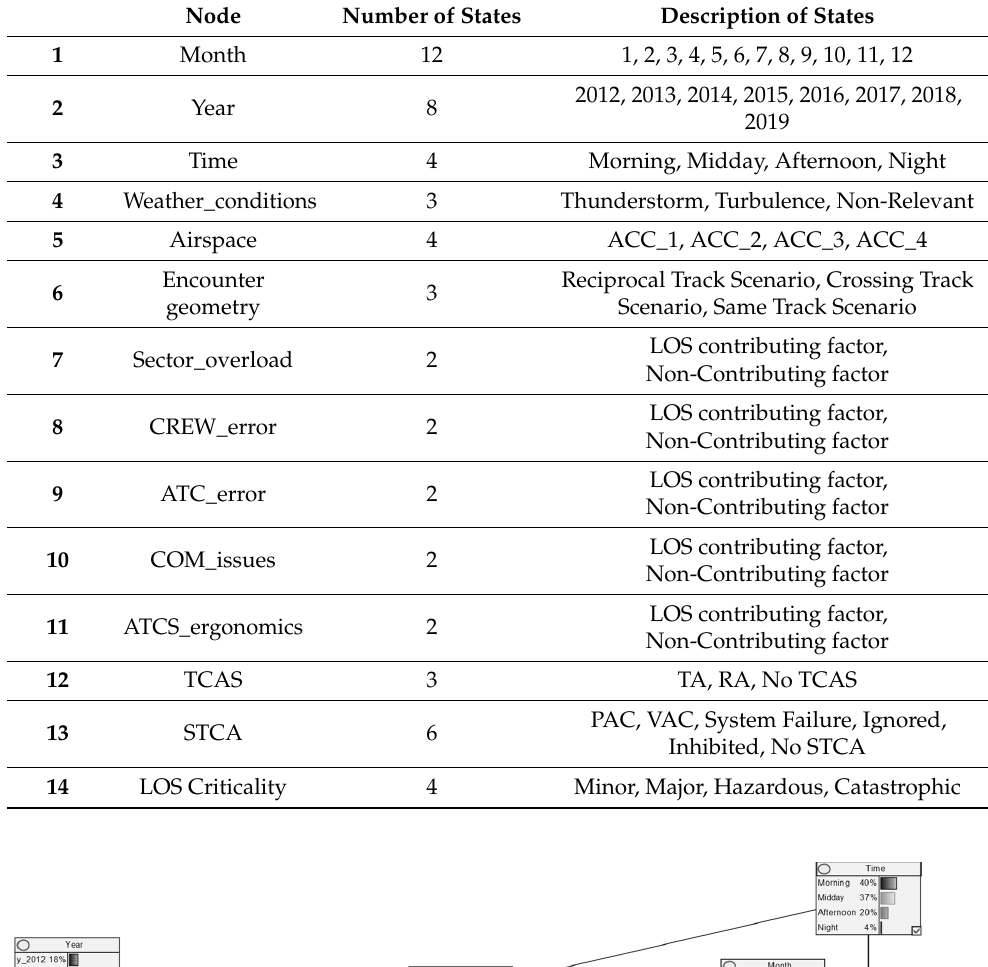
Table 7. Nodes and associated states for incident analysis.